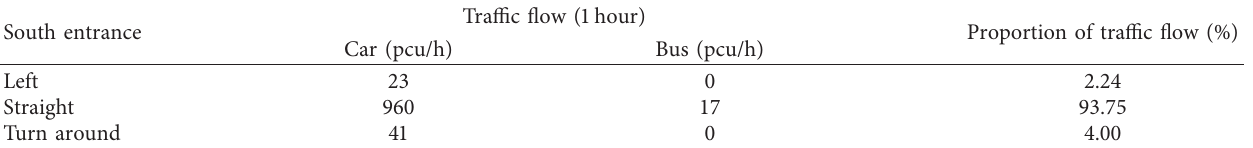
Table 9: Evening peak hour traffic flow near the